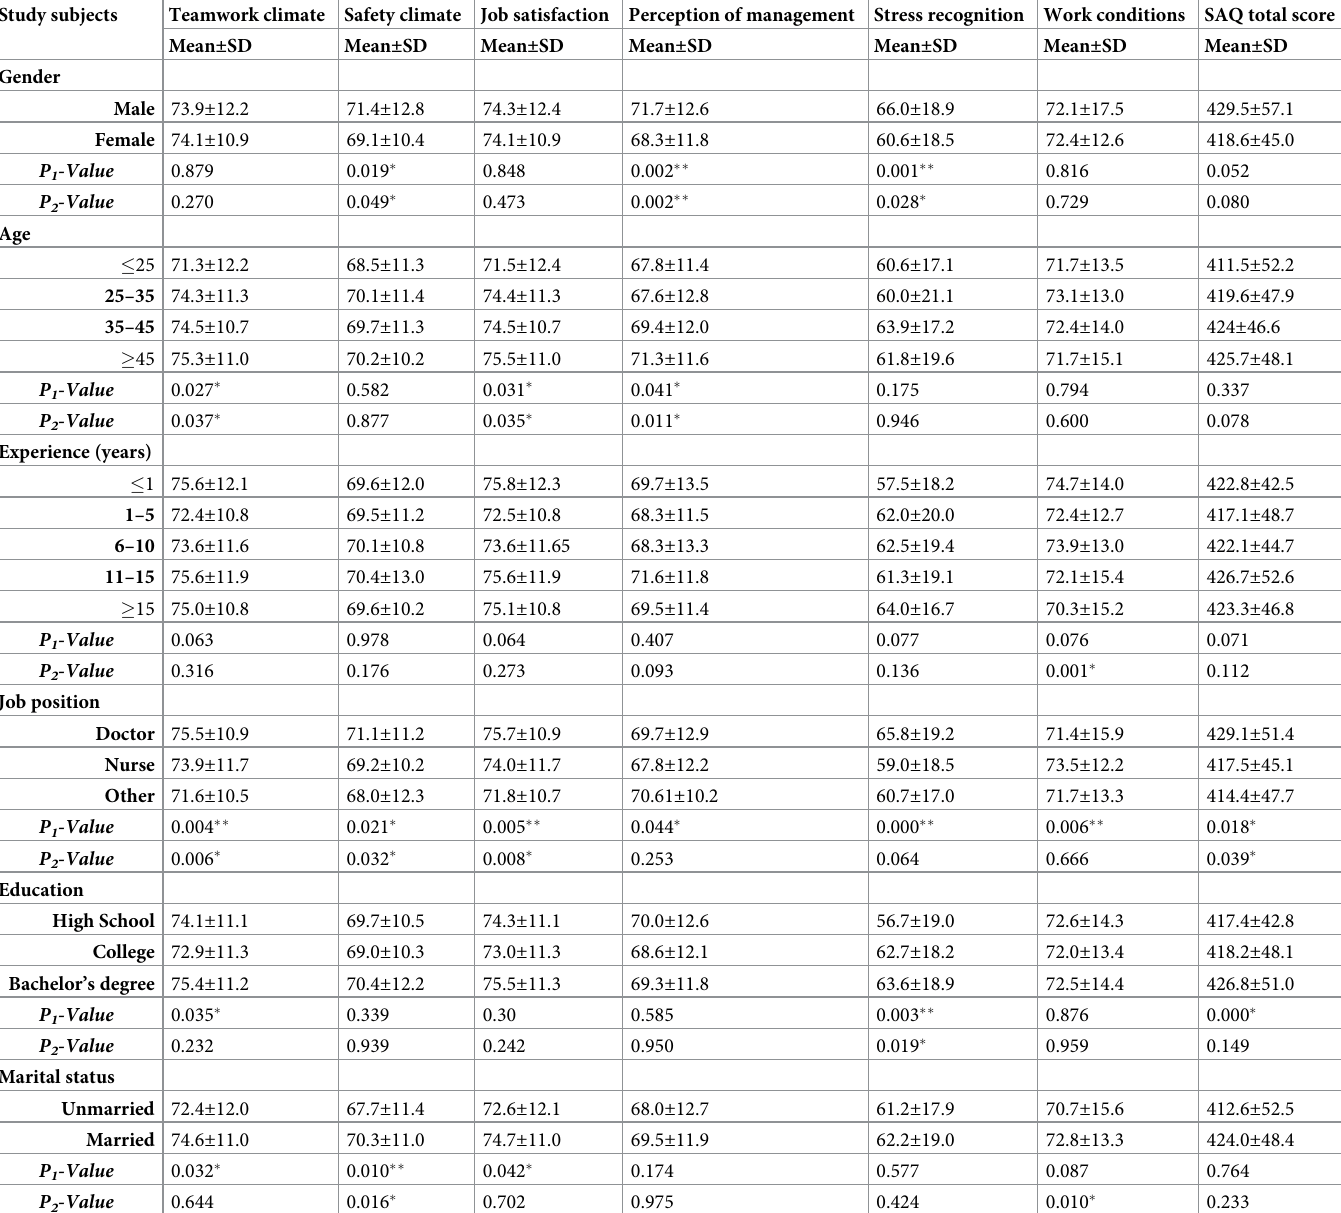
Table 3. Respondents’ perception of patient safety culture